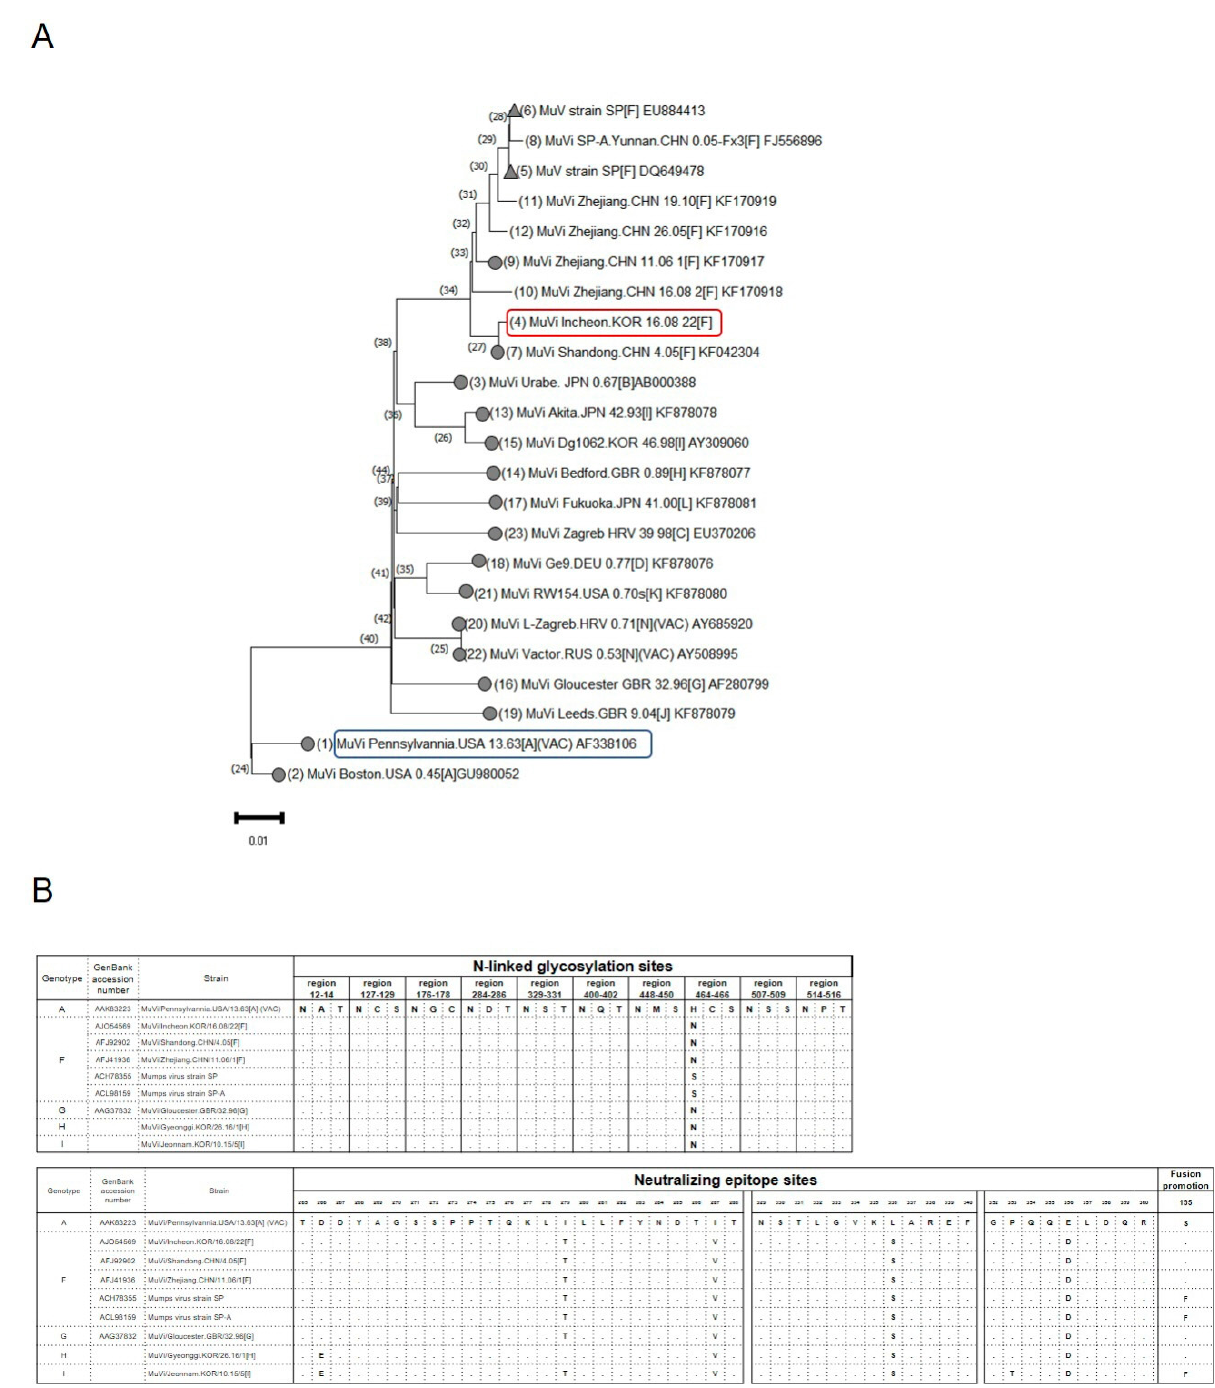
Figure 4. Phylogenetic analysis. (A) Whole genome sequencing (WGS) phylogenetic tree. The WGS phylogenetic tree was constructed using the nearly complete genomes (15,349 nucleotides) of wild-type Korean MuV isolates, strain SP, which has been previously studied as an attenuated vaccine labeled with triangles, and 16 WHO reference viruses labeled with circles in NCBI’s GenBank sequence database. The blue box is the current vaccine strain and red box is the inactivated F genotype mumps vaccine (F10) which is the candidate developed in this study. ( B ) N-linked glycosylation sites and neutralizing epitope sites of HN protein sequences were compared between the wild-type and vaccine strains (MuVi. Pennsylvania.USA.13.63) MuV. Fusion promotion site amino acid 195 of the F protein in the wild-type and vaccine strain MuV.